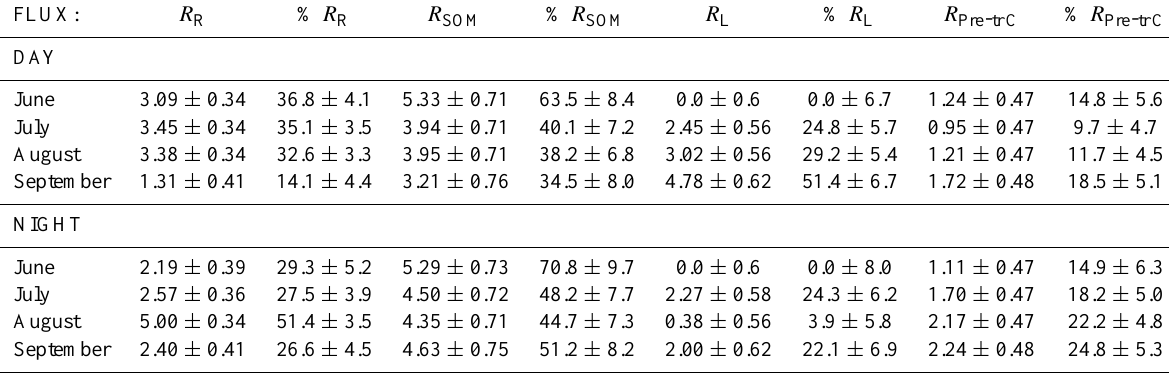
Table 2. The CO 2 efflux rates and the relative contribution of root ( R R ), soil organic matter ( R SOM ), litter ( R L ) and pre-treatment C (fixed by the ecosystem up to the year 1996; R Pre - trC ) components of soil respiration during the day and at night in treatment plots at FACTS-1 over the growing season of 2004. Respiration rates are expressed in µmolCO 2 m − 2 s − 1 and show average values ( n = 3) ± standard error.